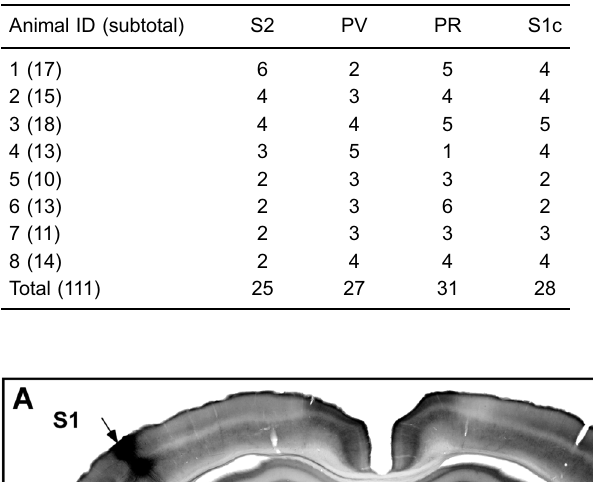
Table 1 . Number of primary somatosensory area (S1) feedfor- ward fragments axon terminals to secondary somatosensory area (S2), parietal ventral area (PV), parietal rhinal area (PR) and contralateral primary somatosensory area (S1c) reconstructed